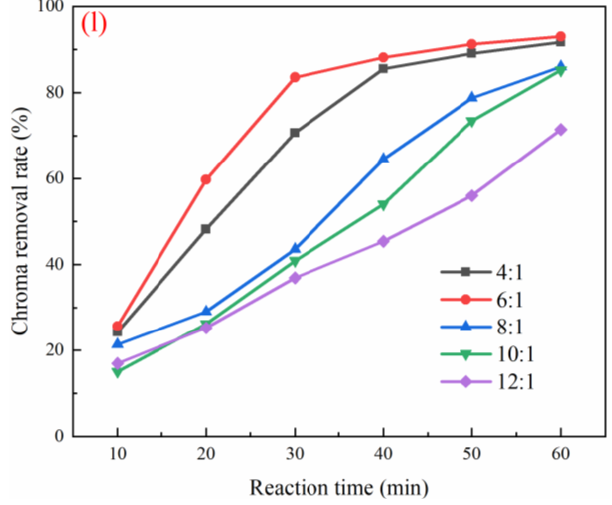
Figure 3. Effect of pH ( a – c ), gas flow rate ( d – f ), catalyst filling ratio ( g – i ), height to diameter ( j – l ) on removal performance of COD, total phenol, and chroma.